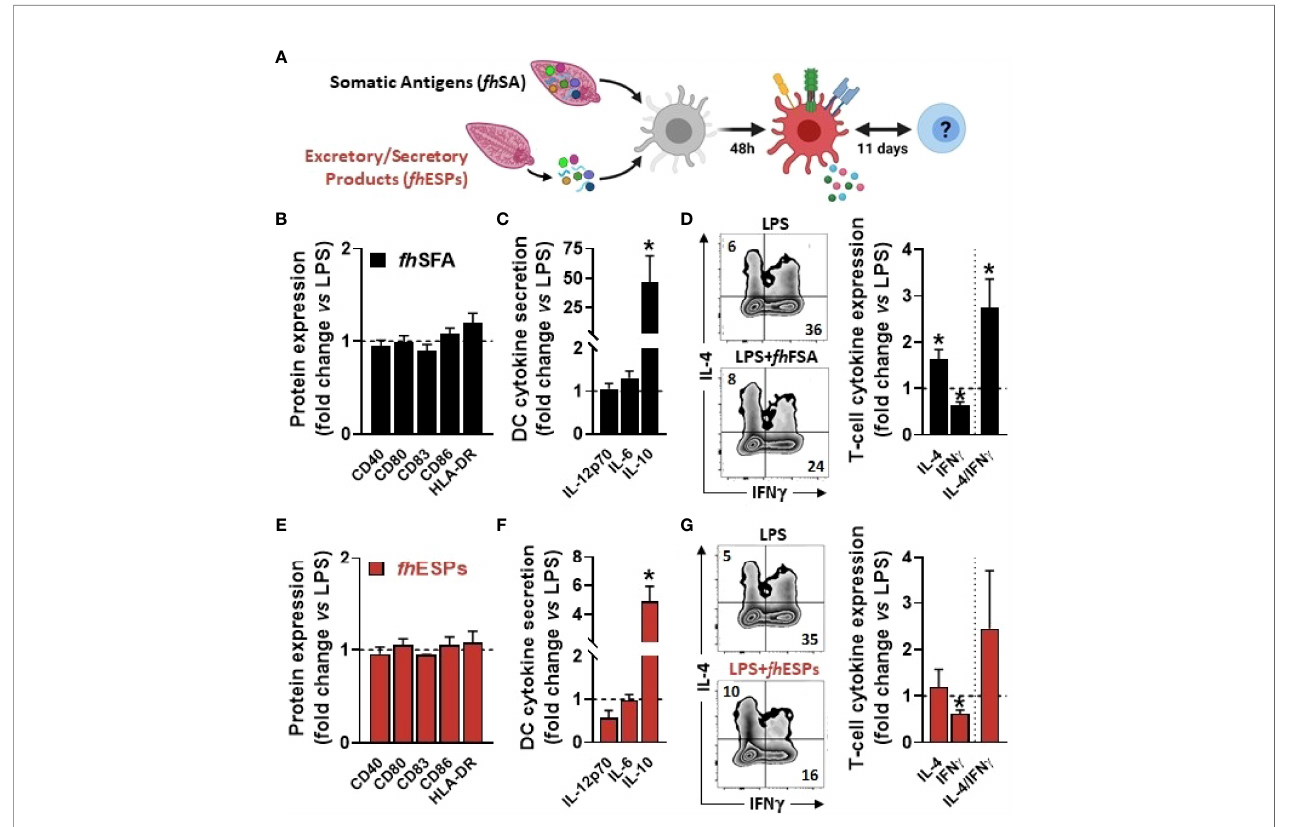
FIGURE 1 | Native Fasciola hepatica molecules modulate Th1/Th2 skewing by LPS-stimulated dendritic cells. Human monocyte-derived DCs (moDCs) were treated with or without F hepatica somatic antigens ( fh SFA, 25 µg/ml) or excretory-secretory products ( fh ESPs) in the presence of LPS (100 ng/ml) (A) After 48 hours, the cell-surface expression of co-stimulatory molecules (B, E) and cytokines production by moDCs (C, F) were determined by fl ow cytometry and ELISA, respectively moDCs primed with or without fh SFA and fh ESPs were cultured with allogeneic naïve CD4 + T cells for 11 days in the presence of SEB and IL-2 Intracellular IL-4 and IFN g expression was assayed by fl ow cytometry 6 hours after restimulation with PMA and ionomycin (D, G) , and the IL-4-on-IFN g ratio calculated One representative experiment is shown for the Zebra plot All data are expressed relative to the DCs stimulated with LPS alone (dash line) as mean ± SEM * P ≤ 005 vs LPS alone (n=3 independent